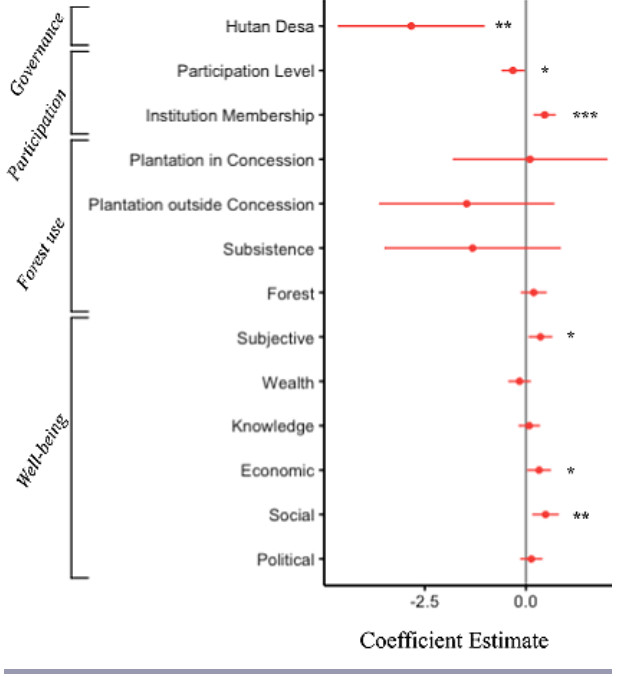
Fig. 5 . Coefficient estimates from cumulative link mixed model with procedural satisfaction as the response variable.